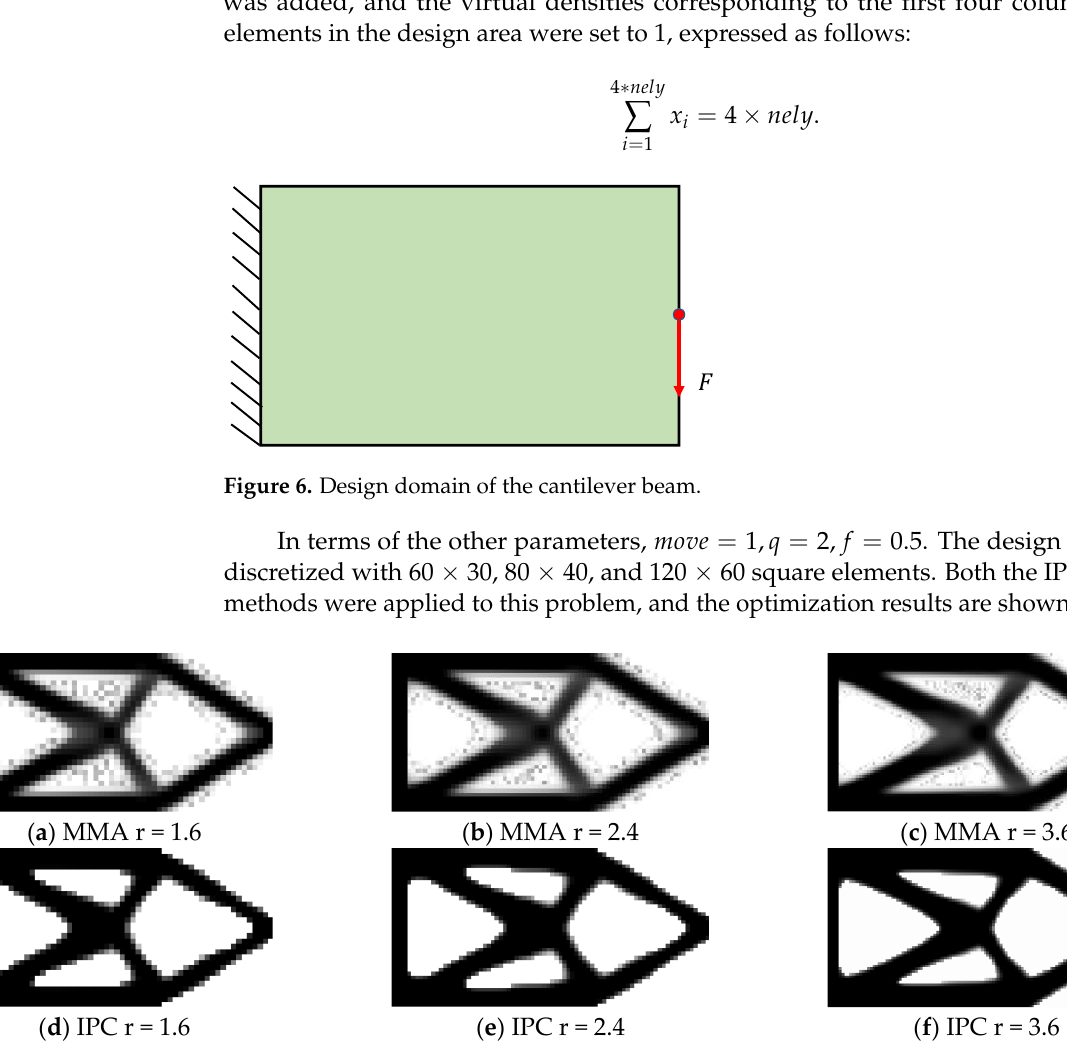
Figure 5. Comparison of optimization indices obtained using different methods.